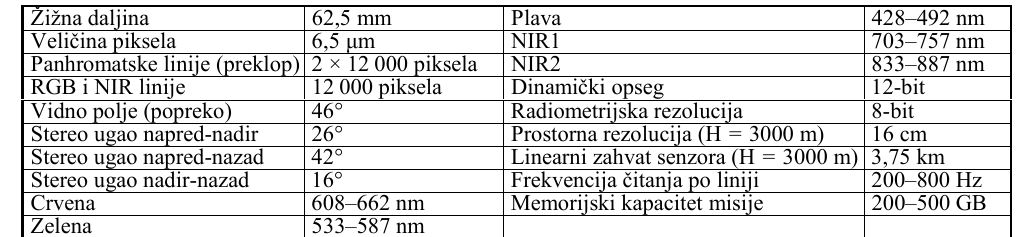
Fokusna ravan sadr ž i CCD linije